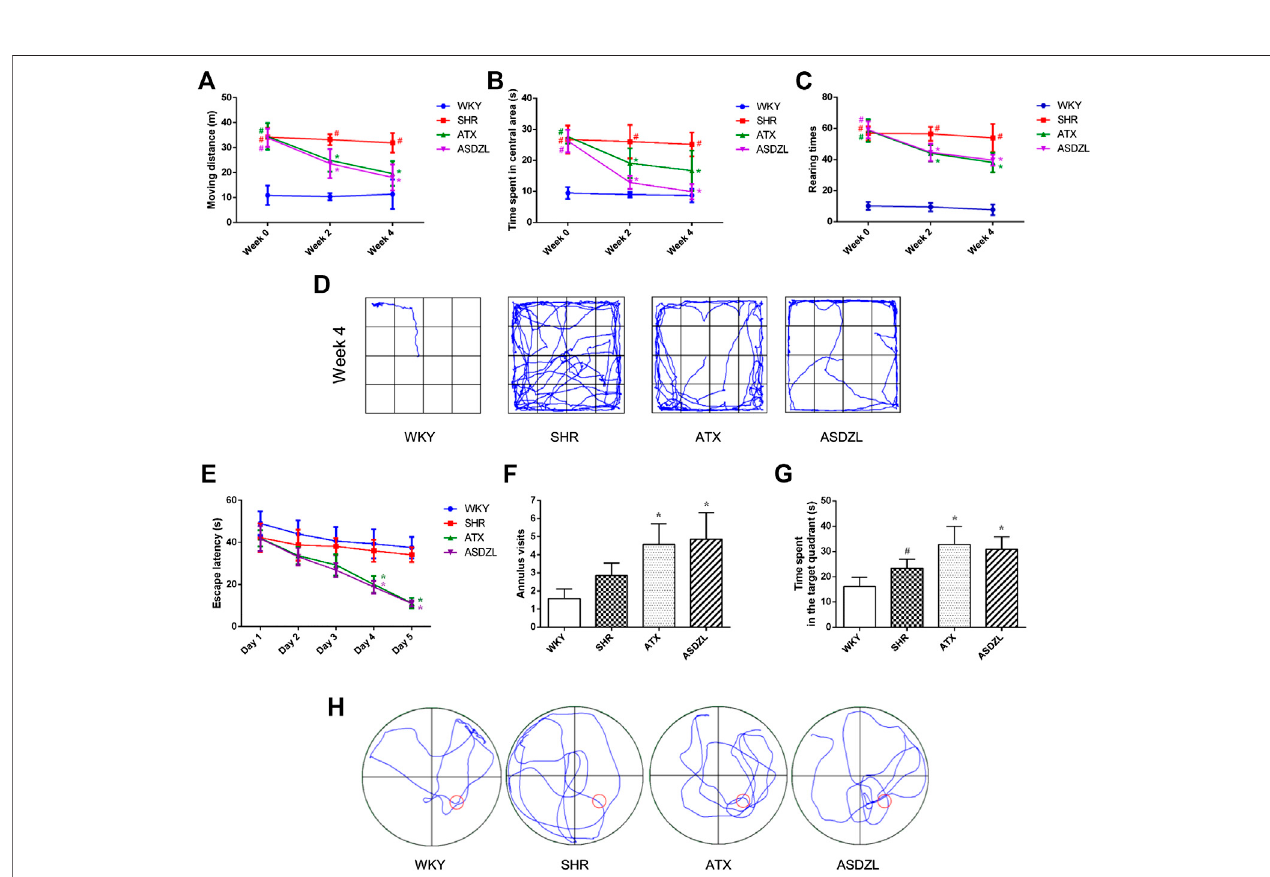
FIGURE 2 | Behavioral performance in OFT and MWM. (A) Moving distance in OFT (m); (B) Time spent in the central area in OFT (s); (C) Rearing number in OFT; (D) RepresentativetrajectoriesofeachgroupinOFT; (E) EscapelatenciesinspatialacquisitiontrialofMWM; (F) NumberofannulusvisitsinprobetrialofMWM; (G) Time spentinthetargetquadrant(s)inprobetrialofMWM; (H) RepresentativetrajectoriesofeachgroupinMWM.Alldataarepresentedasmean ± SD, n (cid:2) 10foreachgroup. # p < 0.05 SHR vs. WKY group, *p < 0.05, compared to SHR group.